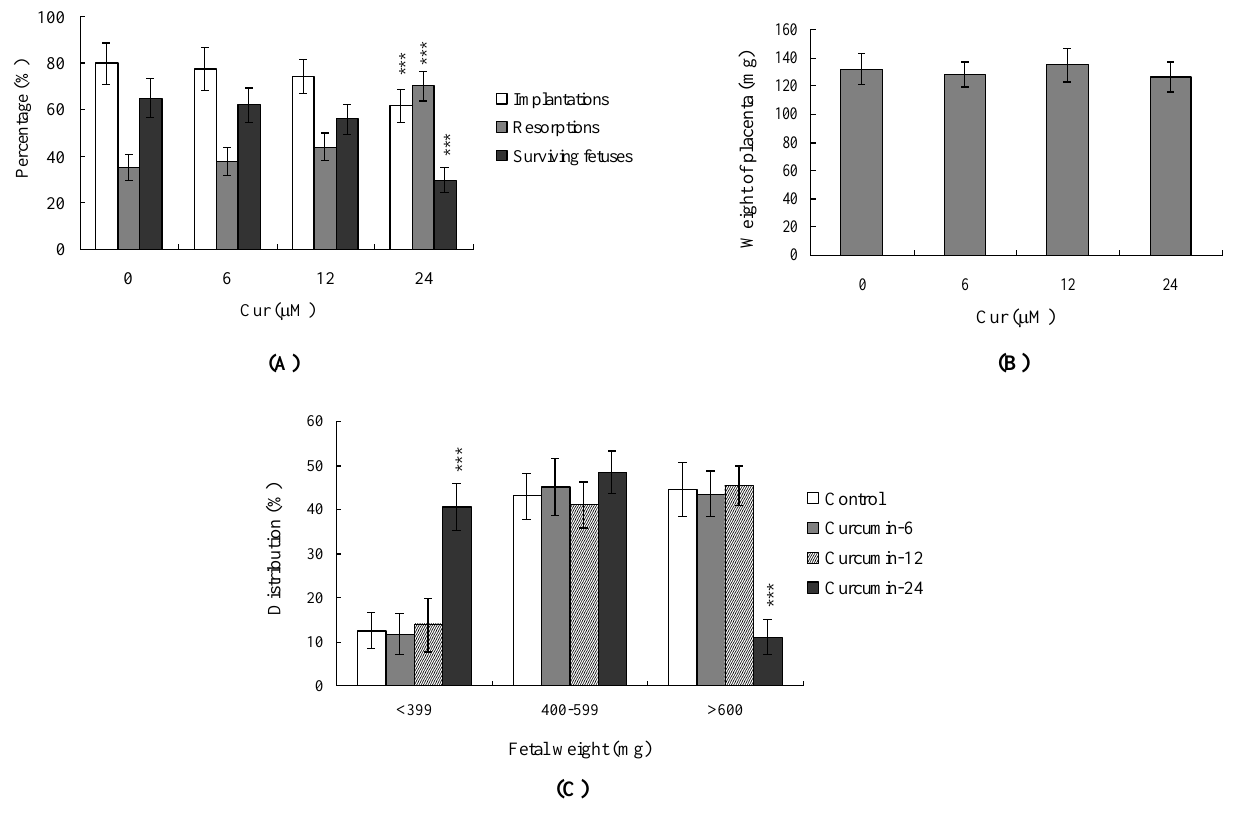
Figure 4. Effects of curcumin on mouse blastocysts on in vivo implantation, resorption, fetal survival and fetal weight. (A) Mouse blastocysts were treated with curcumin (Cur, 6, 12 or 24 μM) for 24 h or left untreated. Implantations, resorptions and surviving fetuses were analyzed, as described in Materials and Methods. The percentage of implantations represents the number of implantations per number of transferred embryos × 100. The percentage of resorptions or surviving fetuses denotes the number of resorptions or surviving fetuses per number of implantations × 100. (B) Placental weights of 40 recipient mice were measured. (C) Weight distribution of surviving fetuses on day 18 post-coitus. Surviving fetuses were obtained by embryo transfer of control and curcumin-pretreated blastocysts, as described in Materials and Methods (320 total blastocysts across 40 recipients). *** P < 0.001 versus the curcumin-free